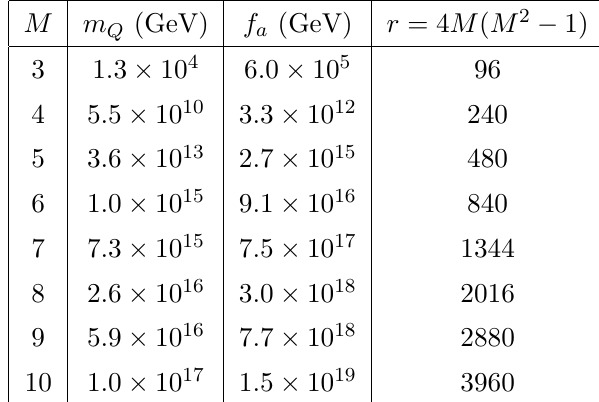
Table 2 . For a given choice of M for an SU( M ) h gauge group, the smallest m Q and corresponding decay constant f a for which we do not hit a Landau pole below 10 18 GeV, and the corresponding enhancement factor r of the axion-photon coupling. We assume all the heavy KSVZ fermions have the same mass m Q = yF 0 where we have chosen y = 0 : 2 as a reference